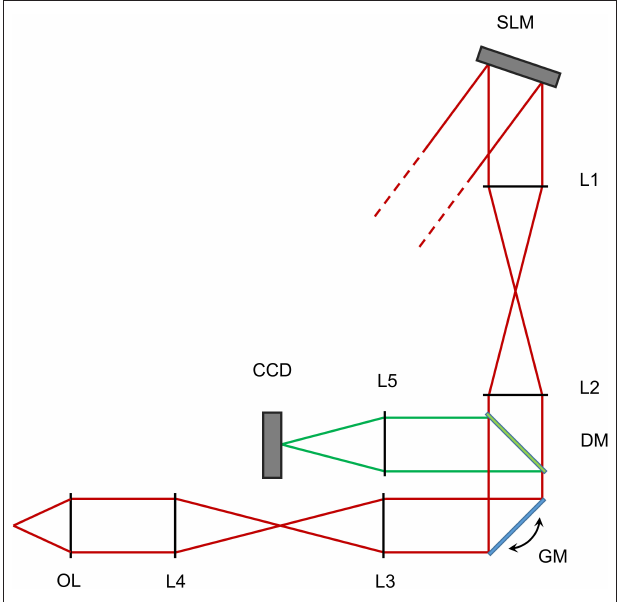
FIGURE 1 | Scheme of the optical setup for the reported experiments. Not to scale. Red lines show the excitation light path, green lines represent the fluorescent light path after descanning. SLM - Spatial light modulator. L1-L2 - First 4f telescope. GM - Galvanometric mirrors. L3-L4 - Second 4f telescope. OL - Objective lens. DM - Dichroic mirror. L5 - Focusing lens. CCD - Detector